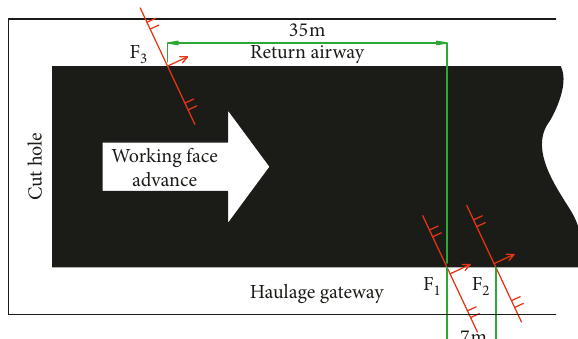
Figure 1: Fault distribution of the working face.